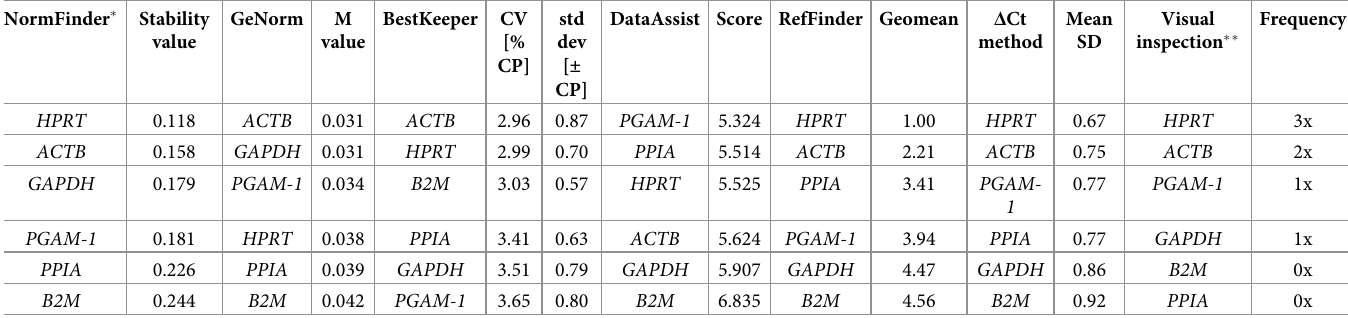
Lower values indicate increased stability in gene expression. Each software result is shown in order of stability. � Best reference genes determined by NormFinder when the intra- and intergroup variations were not considered. �� Visual inspection refers to the number of times each gene appears as the top gene in each